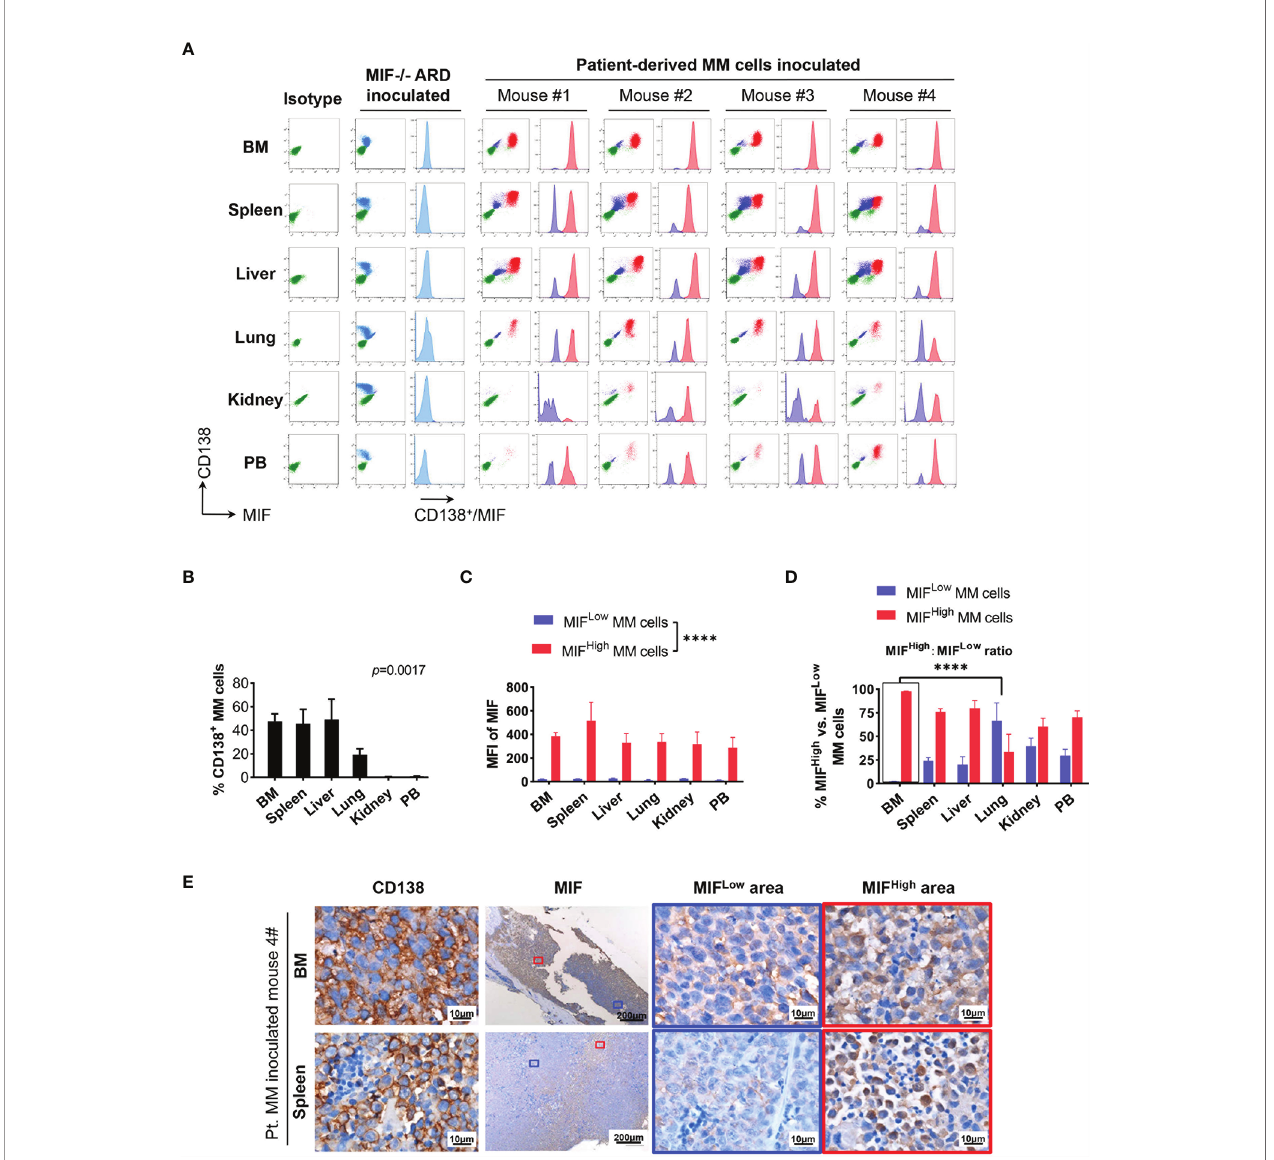
FIGURE 3 | Identi fi cation of MIF High and MIF Low MM cells in patient-derived xenografts. (A) Patient #16-derived BM CD138 + cells were intravenously injected into B-NDG mice to generate a PDX model (n = 4). They were euthanized to collect fresh tissue cells for fl ow cytometry within four to fi ve weeks after inoculation. Mice received MIF − / − ARD cells were used as negative controls. Representative plots show the expression pro fi les of CD138 and MIF in isolated cells. Green represents CD138 − cells, namely non-MM cells; light blue represents MIF − MM cells, dark blue represents MIF Low MM cells, red represents MIF High MM cells. (B) Percentage of in fi ltrating CD138 + MM cells varies considerably in collected samples (n = 4). P = 0.0017 (two-way ANOVA). (C) Compare mean fl uorescence intensity (MFI) of MIF between MIF High and MIF Low populations in diverse samples. The mean value ± standard deviation is 362.5 ± 81.8 and 19.5 ± 5.5 respectively. **** p < 0.0001 (two-way ANOVA). (D) Ratio of MIF High /MIF Low MM cells is notably higher in BM compared to extramedullary samples. **** p < 0.0001 (student ’ s t -test). (E) Representative IHC staining images of paired FFPE samples show sheets of MIF Low CD138 + cells surrounded by MIF High ones, and more evident loss of MIF expression in EMM (spleen) than in IMM (the blue and red boxes indicate representative areas of MIF Low and MIF High MM cells,